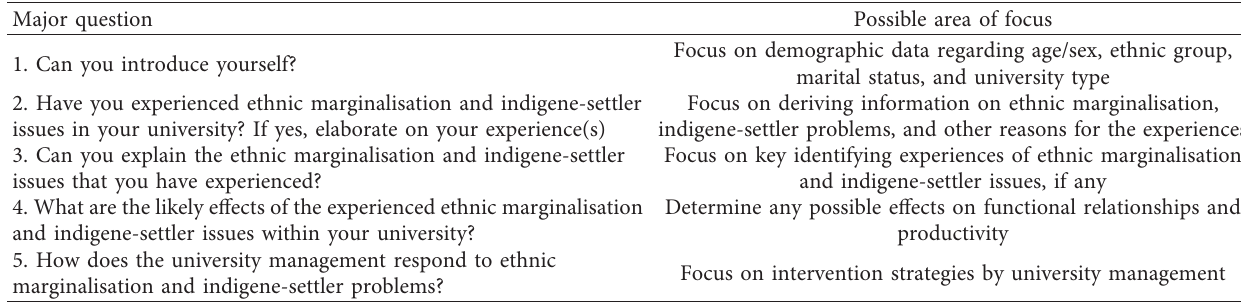
Table 2: Interview questions and possible probing